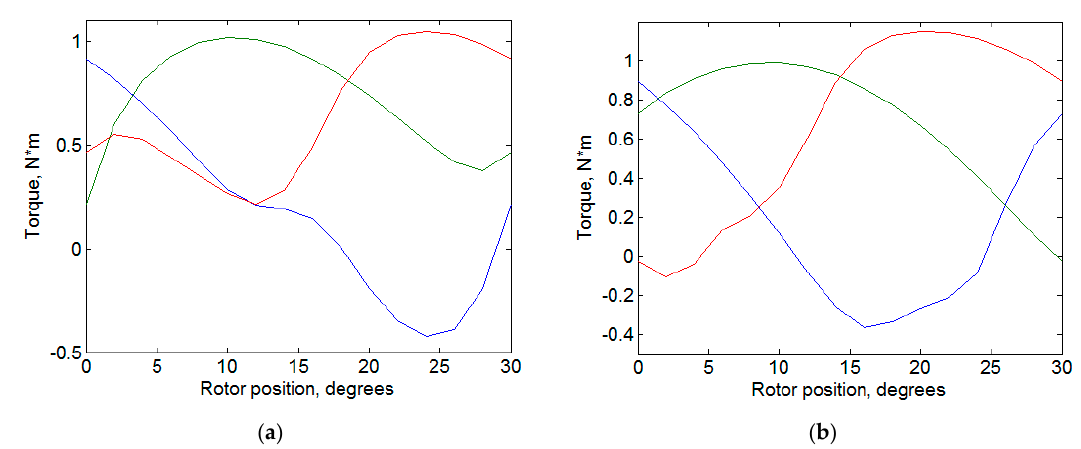
Figure 9. Another representation of the single-phase FRM torque ripple: ( a ) Before optimization; ( b ) after optimization.